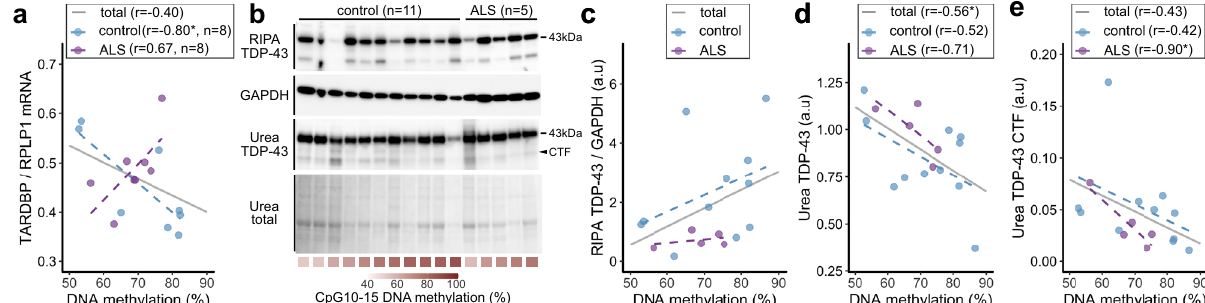
Fig. 7 Effect of DNA methylation on TARDBP expression in the motor cortex. a Scatterplot showing the association between the percentage of DNA methylation of 3 ′ UTR CpGs 10 – 15 and TARDBP mRNA expression relative to the reference gene RPLP1 in eight controls and seven ALS patients (a total of 15 cases). b Western blot analysis of the RIPA-soluble fraction and urea-soluble fraction from the motor cortex of 11 controls and fi ve ALS patients (a total of 16 cases) using an anti-TDP-43 antibody and anti-GAPDH antibody. Total protein in the urea-soluble fraction is also shown. c Scatterplot showing the association between the percentage of DNA methylation of 3 ′ UTR CpGs 10 – 15 and RIPA-soluble full-length TDP-43 protein (43 kDa) expression relative to the reference protein GAPDH. d, e Scatterplot showing the association between the percentage of DNA methylation of 3 ′ UTR CpGs 10 – 15 and the urea- soluble full-length TDP-43 protein (43 kDa) ( d ) and the urea-soluble C-terminal fragment (CTF) of TDP-43 ( e ). Pearson ’ s correlation test, * p < 0.05.